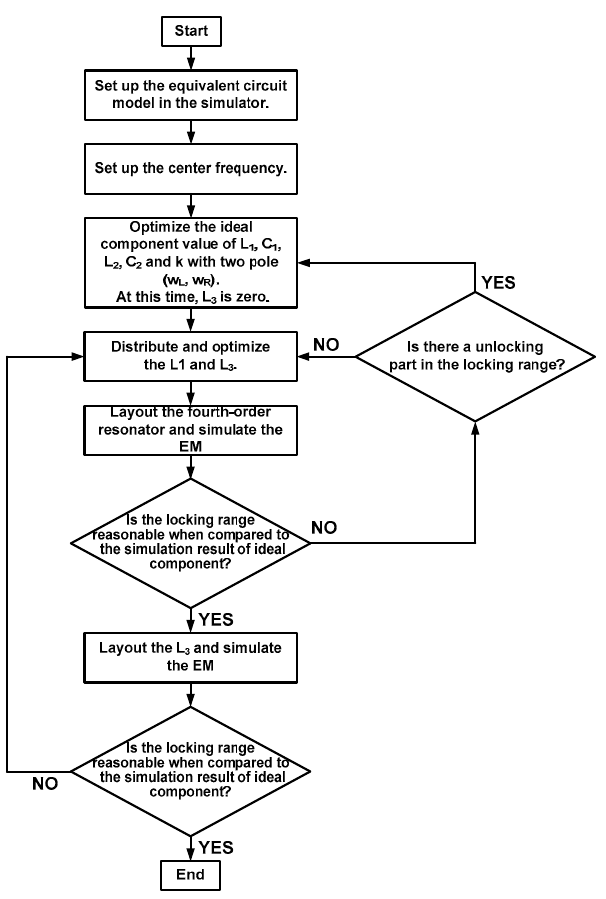
Figure 9. Flowchart of the design approach for the proposed CR-ILFD.